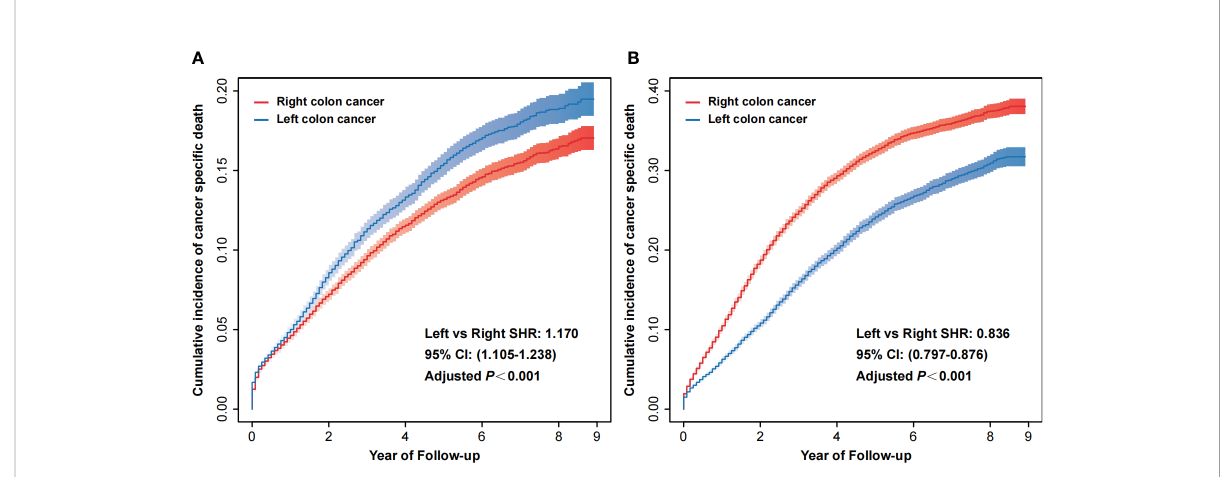
FIGURE 2 Cumulative incidence of cancer-speci fi c death of right colon cancer and left colon cancer in stage I/II (A) and stage III (B) . CI, con fi dence interval; SHR, subdistribution hazard ratio.